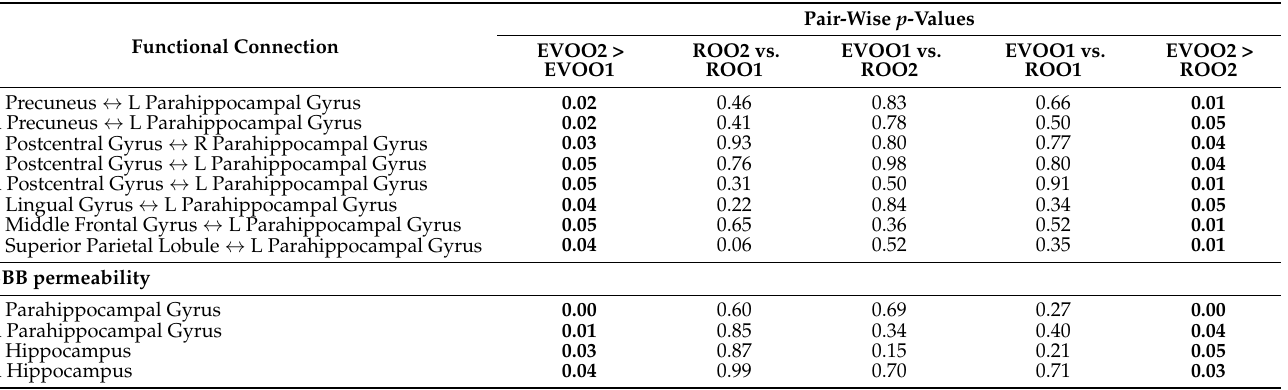
Table 2. Pair-wise statistical comparison of identified functional connections and BBB permeability for ROO and EVOO groups. Bold values indicate significantly